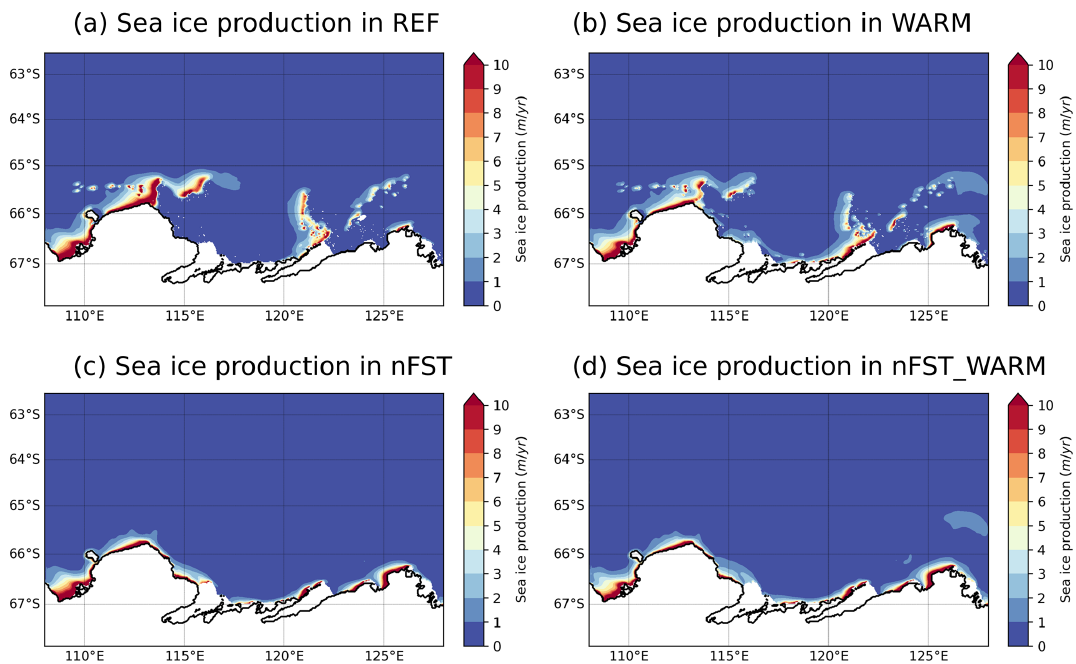
Figure 13. Mean sea ice production for the REF (a) , WARM (b) , nFST (c) and nFST_WARM (d) simulations, all averaged over the 20 years of simulation.